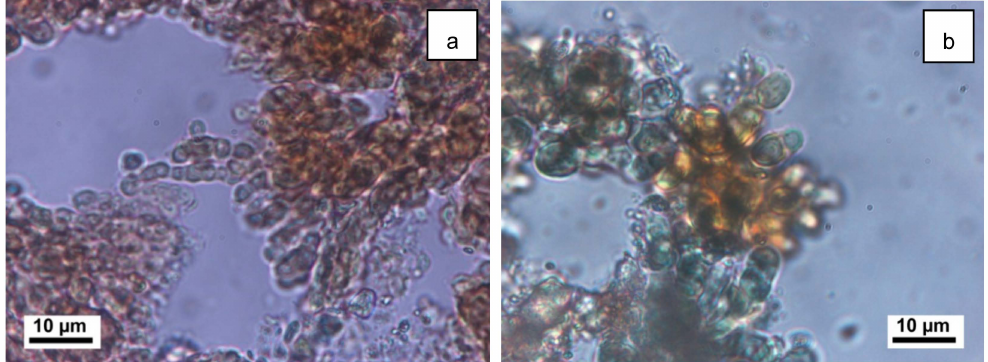
Figure 7. Photograph of samples taken using optical microscopy: ( a ) Pleurocapsa sp. cells are shown on the left; ( b ) Chamaesiphon sp. cells are shown on the right.